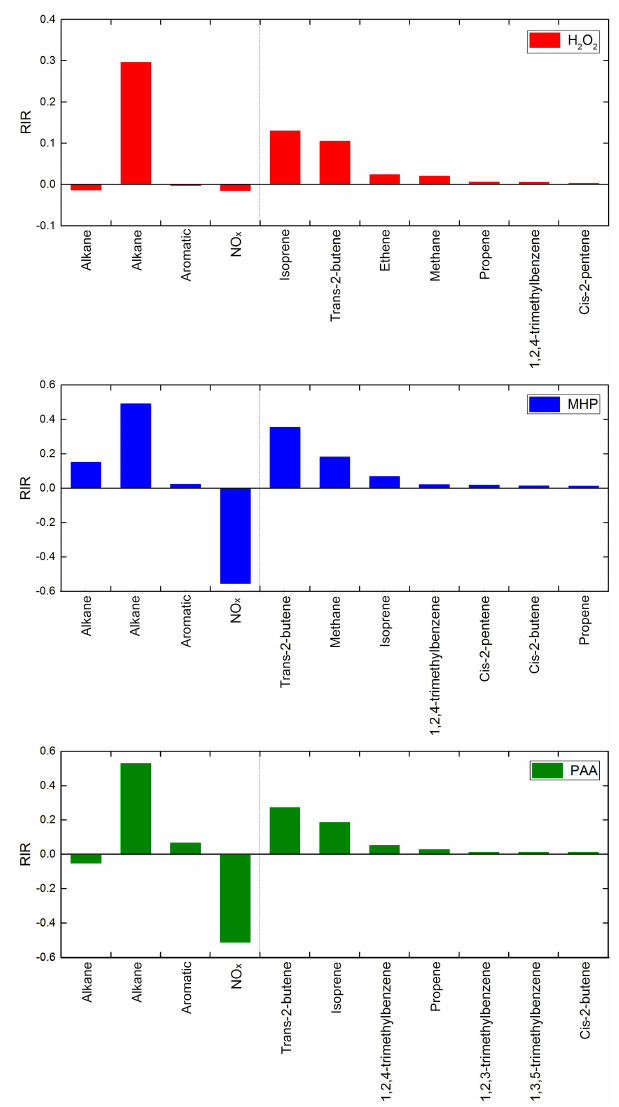
Figure 5. Sensitivity of production rates of atmospheric peroxides to major VOC precursor groups and individual VOC species for Phase I and Phase